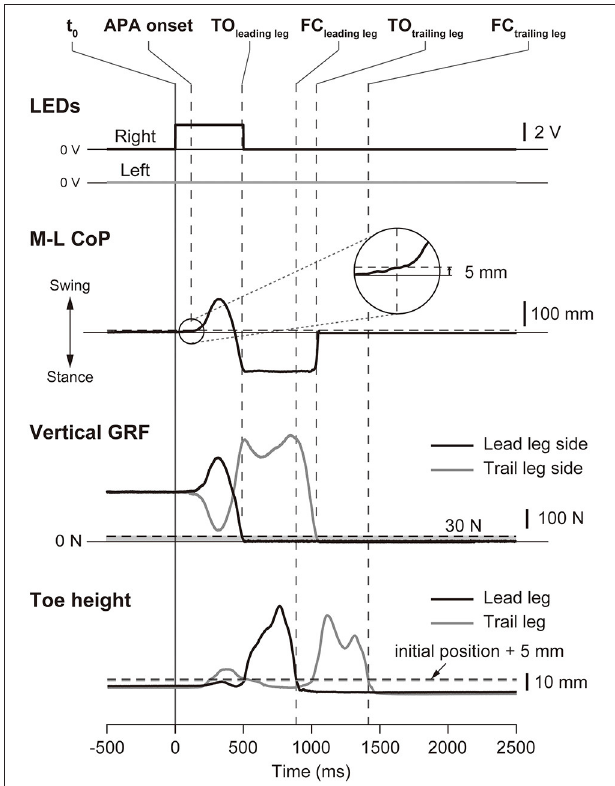
FIGURE 2 | Definitions of the temporal events. The figure shows a typical example of the LED signals, the mediolateral center of pressure (M-L CoP), the vertical ground reaction force (zGRF), and the vertical position of the toes in the small target short distance condition. In this trial, the right LED was illuminated at t0 (vertical solid line), so that the right leg was the leading leg. The time of APA onset was defined as the instant when the M-L CoP deviated by 5mm from its baseline value, the time of takeoff (TO leading and TO trailing ) was defined as the instant when the vertical ground reaction force of the leg decreased below 30N, and the time of foot contact was defined as the first instant when the vertical position of the toe was < 5mm from the initial static posture. These temporal events are shown as vertical dashed lines. TO leading : takeoff of the leading leg; FC leading : foot contact of the leading leg; TO trailing : takeoff of the trailing leg; FC trailing : foot contact of the trailing